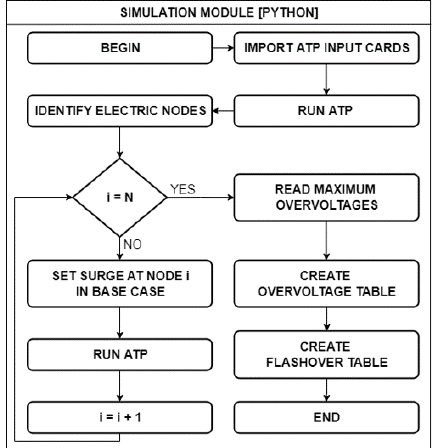
Figure 9. Flowchart of the ATP simulation loop.